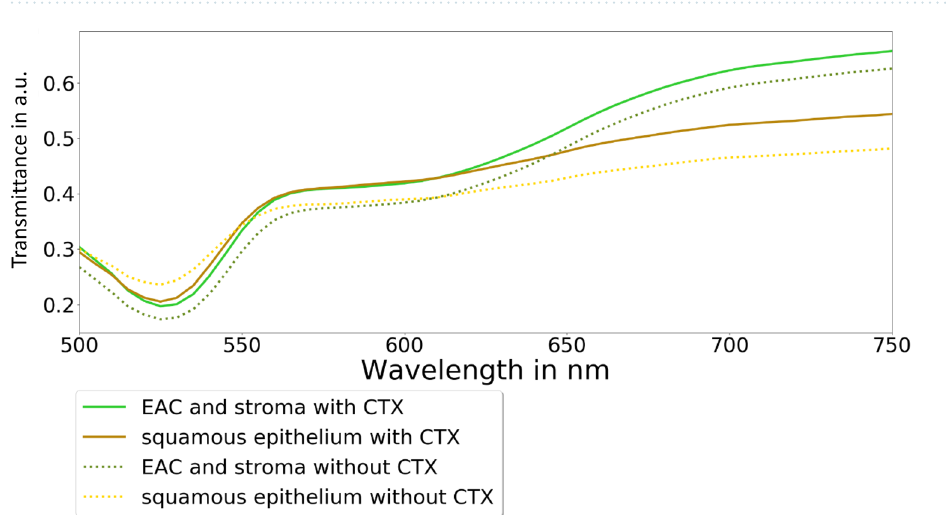
Figure 3. Principal component analysis (PCA) of the four classes were performed with MATLAB R2018b to analyze the class-variance. To show the clusters of the classes, we used only 1000 spectral data of each class. The data were randomly selected.